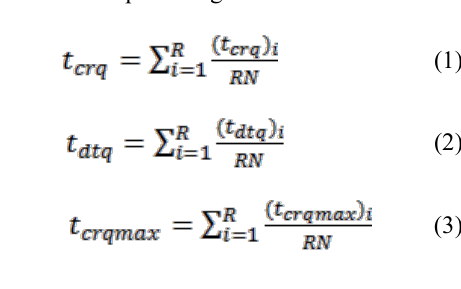
Figure 2. Evolution in time of the collision resolution queue (blue) and data transmission queue (red) when n =1500 sensors and m = 3